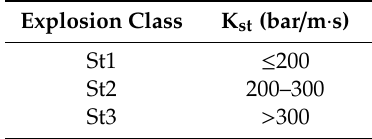
Table 1. The industrial dust explosion classes based on K st value